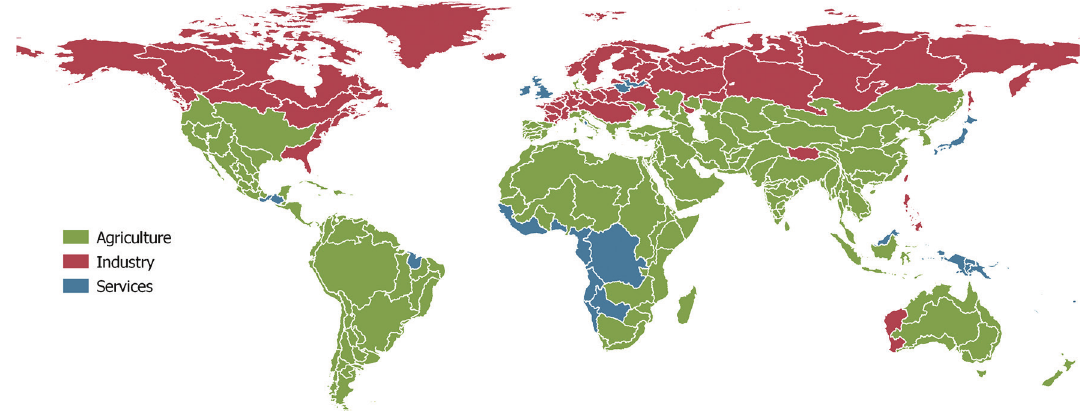
Dominant sector freshwater withdrawal per major river basin (reference year 2018). Geographic projection.